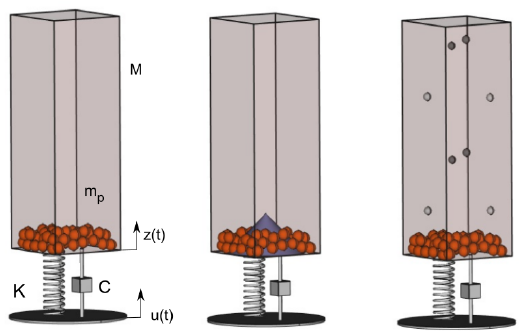
Figure 1. Model of the SDoF system with a granular damper. (Left) Flat enclosure. (Center) Enclosure with conical fl oor. (Right) Enclosure with obstacles.